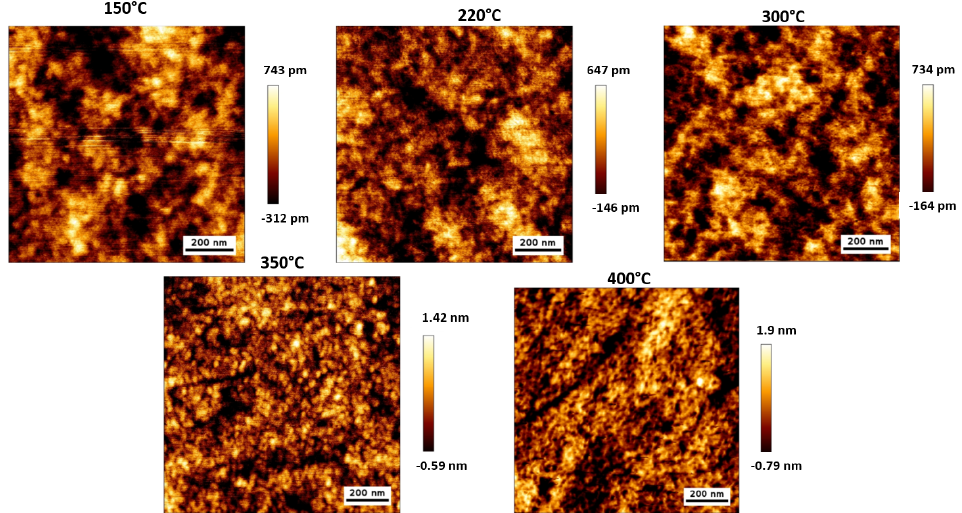
Figure 7. AFM pictures of PSAN film surface with wt = 0.5% annealed at different temperatures. Note that for high annealing temperatures the pictures show straight lines that are present in the bare